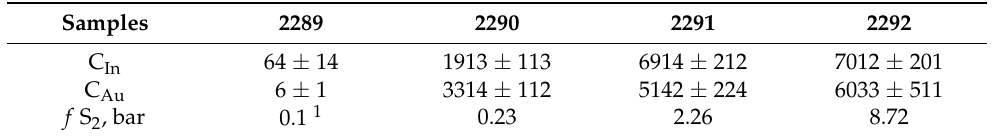
Figure 31. Microphotos of the light-green synthetic sphalerite with admixture of In and Au. ( a ) Sample 2027, ( b ) sample 2032; see Table 24 for details. Figures 31–33 and 40—photos prepared by Timofey Pashko. Table 25. Concentration of In and Au according to LA-ICPMS data (ppm ± 2 σ ) in the crystals grown using the gas transport method with various fugacity of sulphur at 850 ◦ C. Table 24. Concentration of In (C In ) and Au (C Au ) in the crystals grown at 850 °C using gas